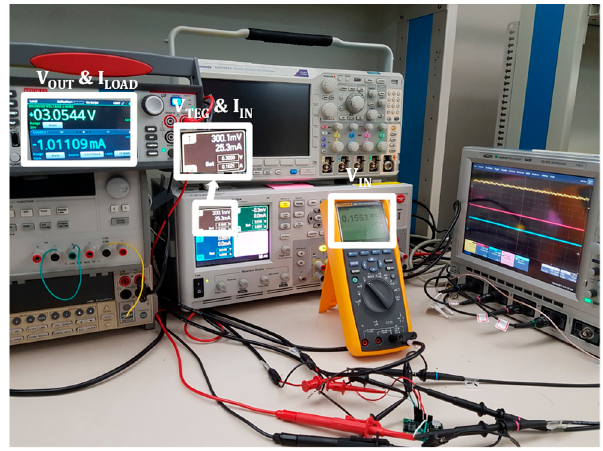
Figure 13. The EMIC measurement environment and efficiency measurement set-up.